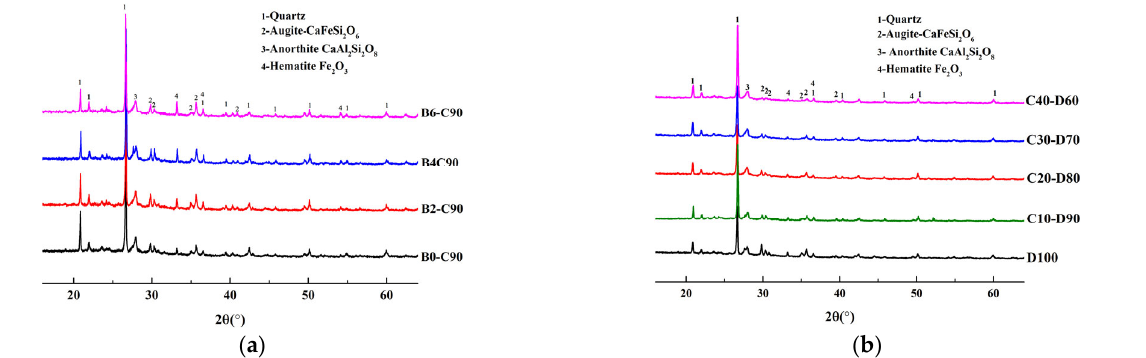
Figure 16. XRD patterns of samples with different ( a ) Fe 2 O 3 contents and ( b ) potassium feldspar